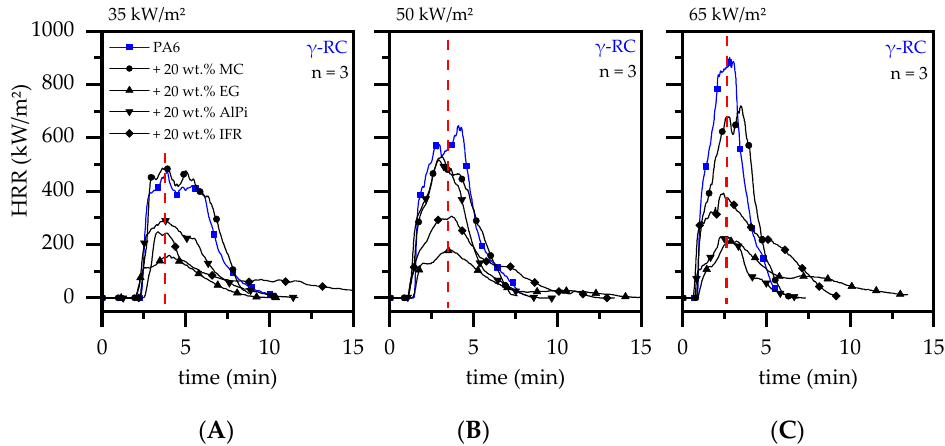
Figure 15. Comparative illustrations of cone calorimeter results conducted at ( A ) 35 kW/m 2 , ( B ) 50 kW/m 2 and ( C ) 65 kW/m 2 for a selection of β‐ RC samples.